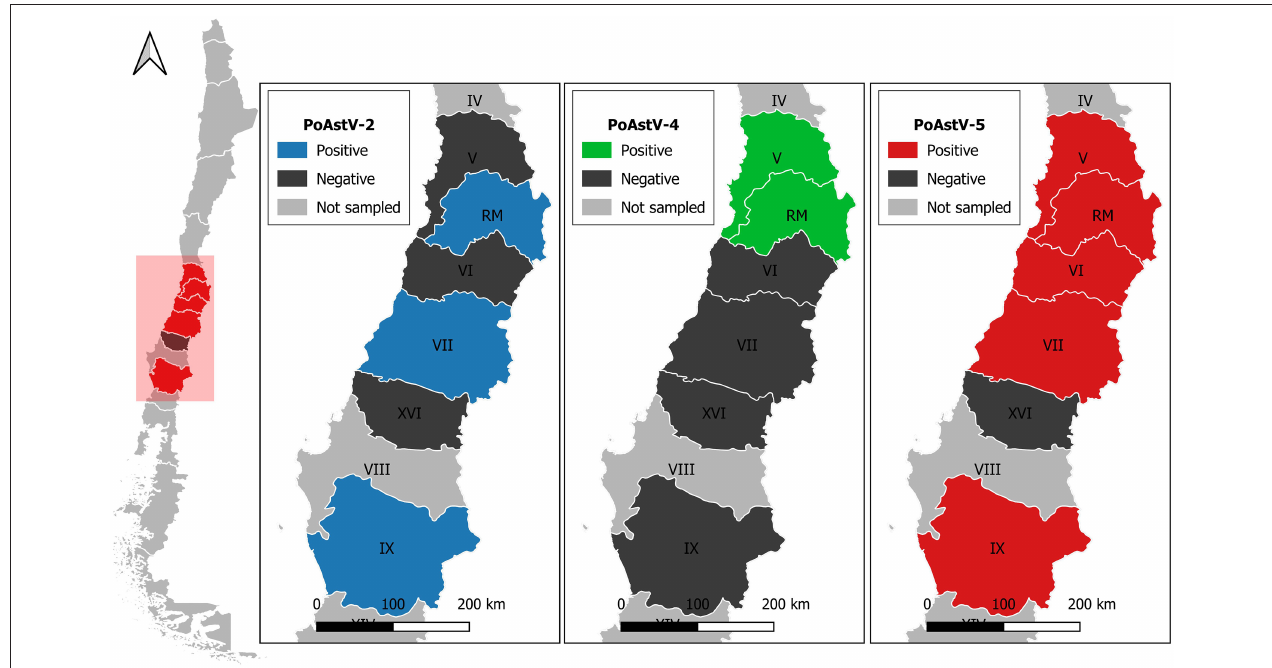
FIGURE 1 | PoAstV strains with > 77% of sequencing coverage were detected in Porcine intensive farms from different regions of Chile. Regions are labeled as V, Valparaíso; RM, Metropolitana; VI, Libertador General Bernardo O’Higgins; VII, Maule; XVI, Ñuble; IX,